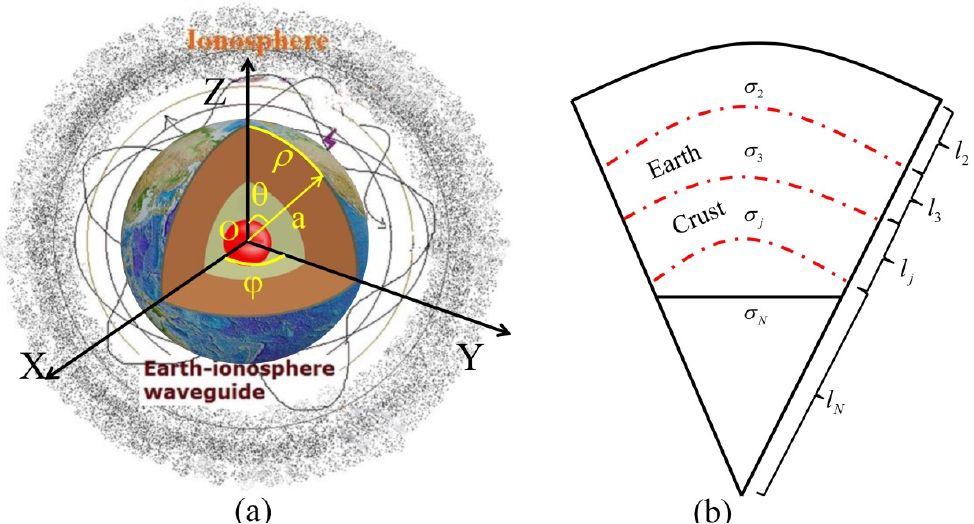
Figure 2. ( a ) “Earth–ionosphere” waveguide model: the solid line represents the schematic diagram of the propagation paths of electromagnetic waves with different frequencies in the waveguide; ( b ) layered Earth model.